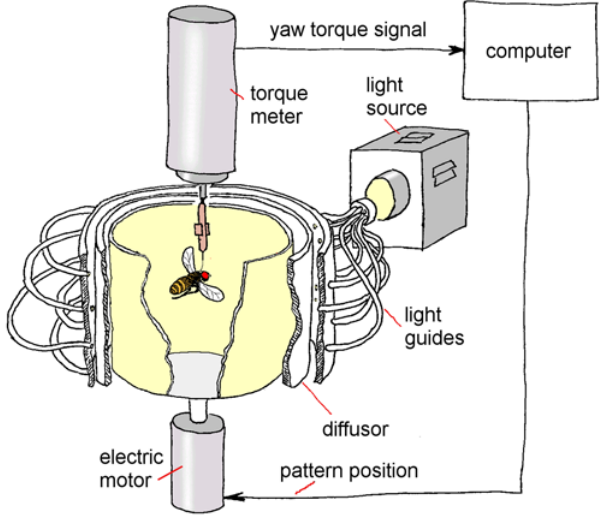
Figure 2. Flight simulator set-up. The fly is flying stationarily in a cylindrical arena homogeneously illuminated from behind. The fly’s tendency to perform left or right turns (yaw torque) is measured continuously and fed into the computer. In closed-loop, the computer controls arena rotation (single stripe or uniform texture as patterns on the arena wall). An additional white screen (not shown) covered the arena from above for all groups.